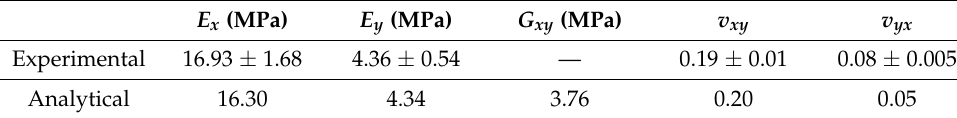
Table 3. Experimental and analytical properties of the [0 G /0 J /0 J /0 G ] laminate. E x (MPa)